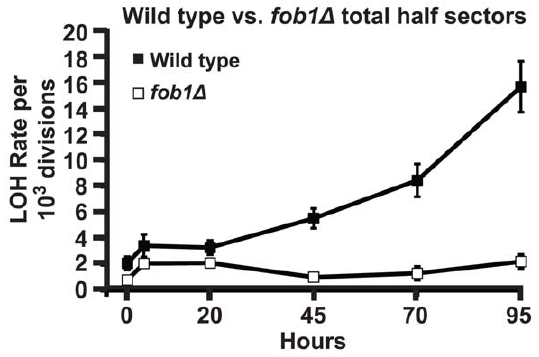
Figure 3. Age-associated LOH events depend on FOB1 . Total LOH rates at MET15 from individual aging cultures of UCC526 ( fob1 D ). Error bars indicate SEM.